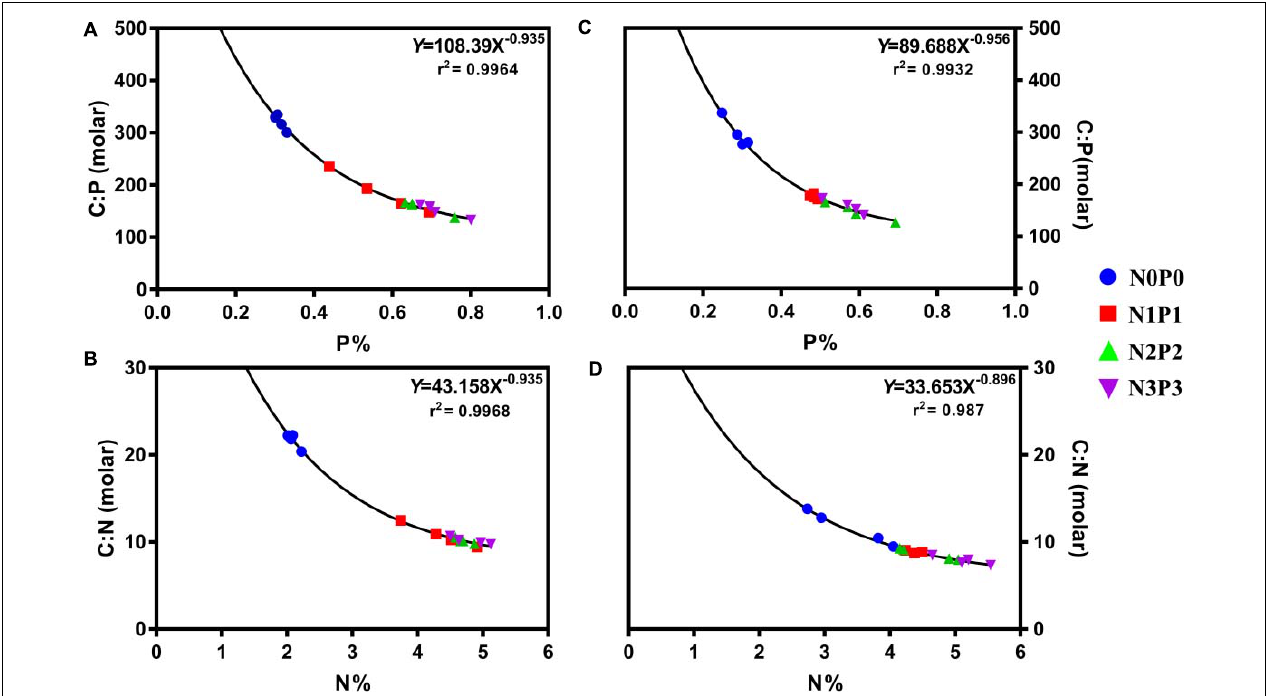
FIGURE 5 | Arithmetic relationships between nutrient contents (percentage dry weight) and nutrient molar ratios, (A) P% and C:P ( r 2 = 0.9964) and (B) N% and C:N ( r 2 = 0.9968) for Z-61; (C) P% and C:P ( r 2 = 0.9932) and (D) N% and C:N ( r 2 = 0.987) for